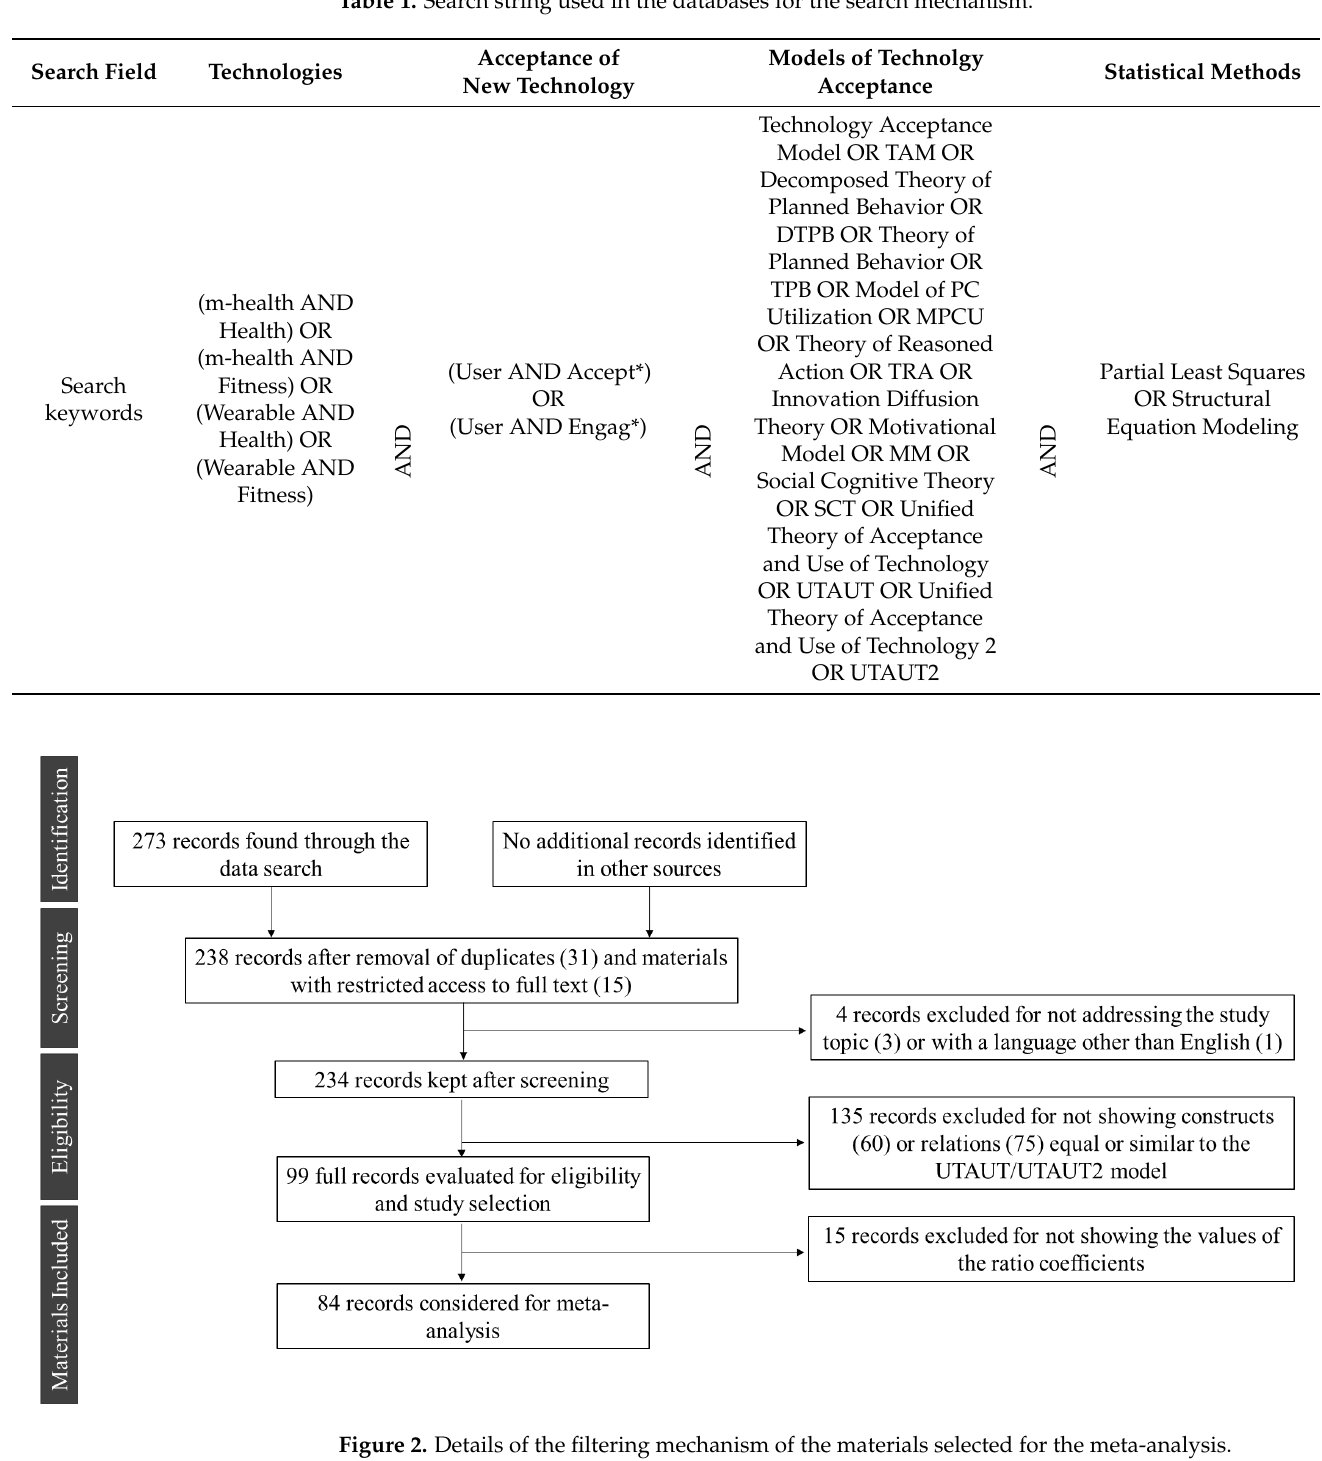
Table 1. Search string used in the databases for the search mechanism.